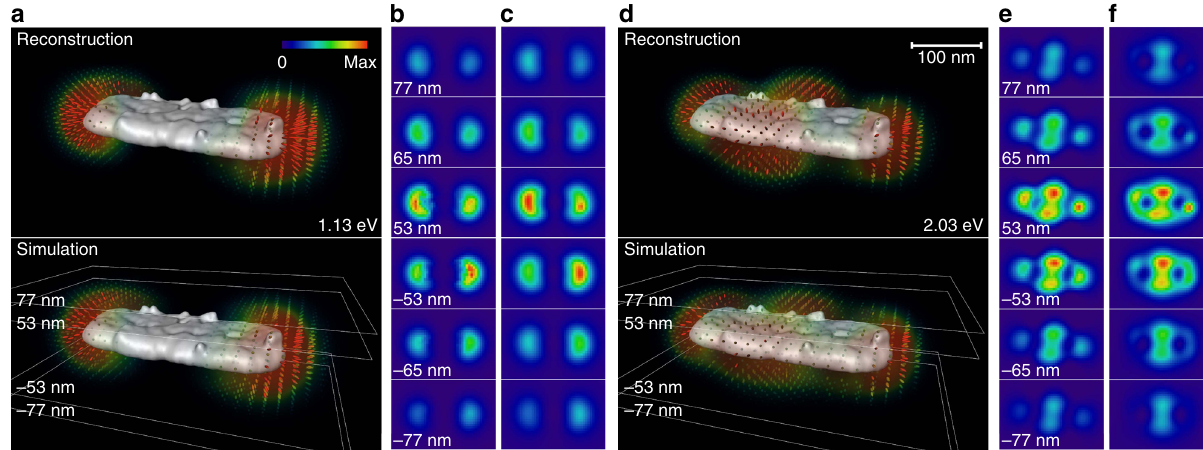
Fig. 3 Reconstructed photonic LDOS for nanocuboid. a Reconstructed and simulated photonic LDOS for the dipole mode of the nanocuboid. The color of the pencils represents the LDOS magnitude, the orientation indicates the direction n along which ρ n ( r ) is maximal. We additionally show the b reconstructed and c simulated averaged LDOS in different layers above and below the nanocuboid. d – f Same as a – c but for the quadrupole mode